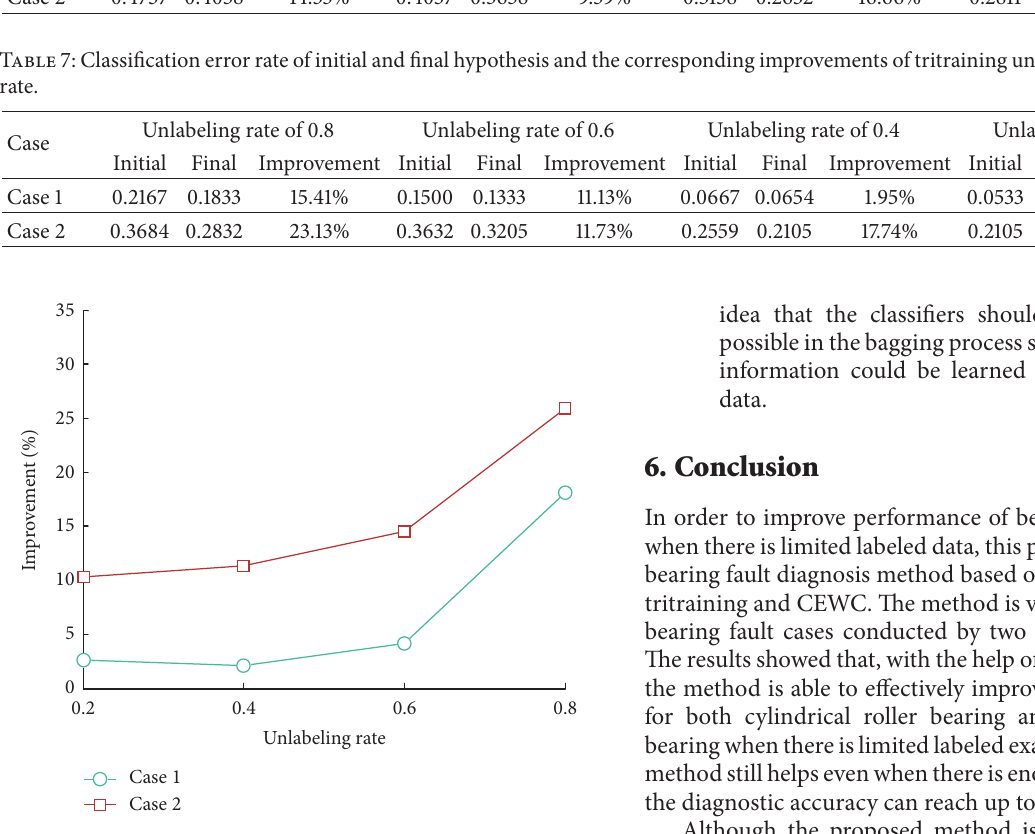
Figure 8: Comparativediagnosis results of rolling bearing diagnosis